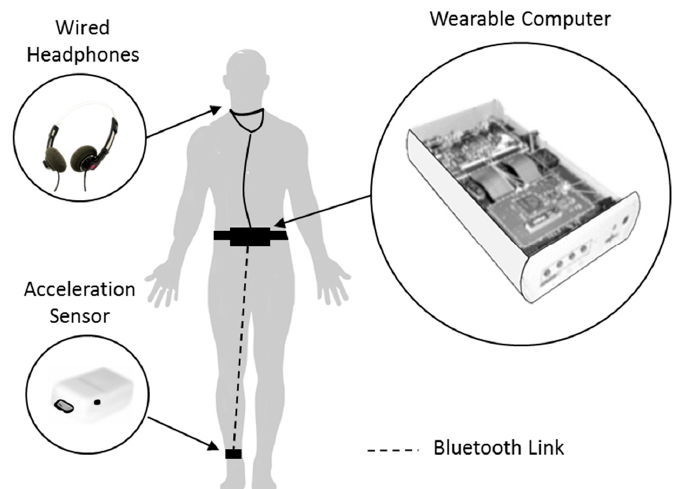
Figure 3. Illustration of user wearing the On ‐ demand auditory cueing system, presented by Bachlin et al. A wired headphone was worn around the neck of the user and connected to a wearable computer that was attached to the lower back. An acceleration sensor was attached to the shin and connected to the wearable computer over a Bluetooth classic communication link.